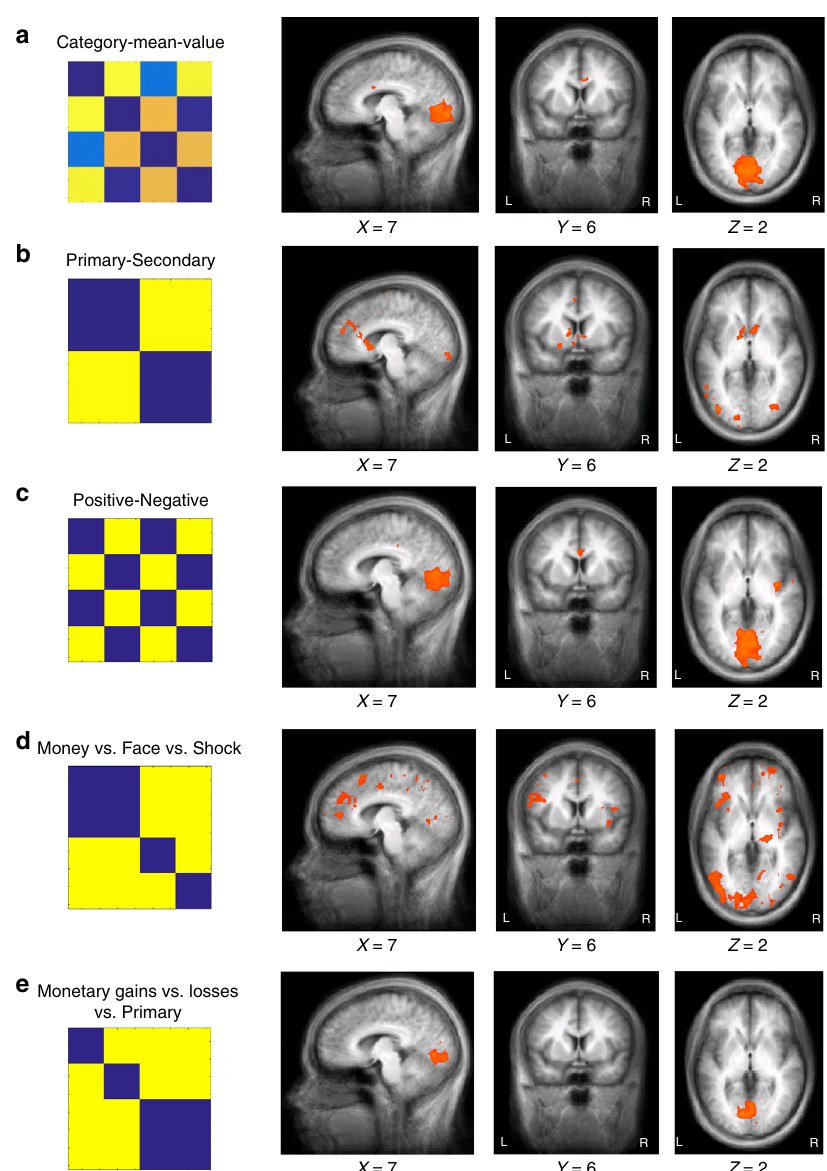
Fig. 6 Whole-brain searchlight RSA for additional control models. Five additional control models for the category model are shown, together with their whole-brain searchlight statistical maps. In each panel, a pseudo colored candidate model RDM for the corresponding model is shown on the left. Warmer colors indicate greater distance and thereby larger dissimilarity. The order of the conditions is the same as in Fig. 5a. For each model, whole-brain maps of the z -statistic of the resemblance between the candidate model RDM and the neural RDMs are shown on the right. Statistical thresholds for all maps were per-voxel p < 0.005 and cluster-size thresholding at FWE p < 0.05 by simulation of 1000 random samples. To facilitate comparison, all maps are presented from the same planes as in Fig. 5b for the category model. a The category-mean-value model from a representative participant. b The primary-secondary model. Because this model does not involve ratings, all participants have the same model RDM (same below). c The positive-negative model. d The money vs. face vs. shock model. e The monetary gains vs. monetary losses vs. primary